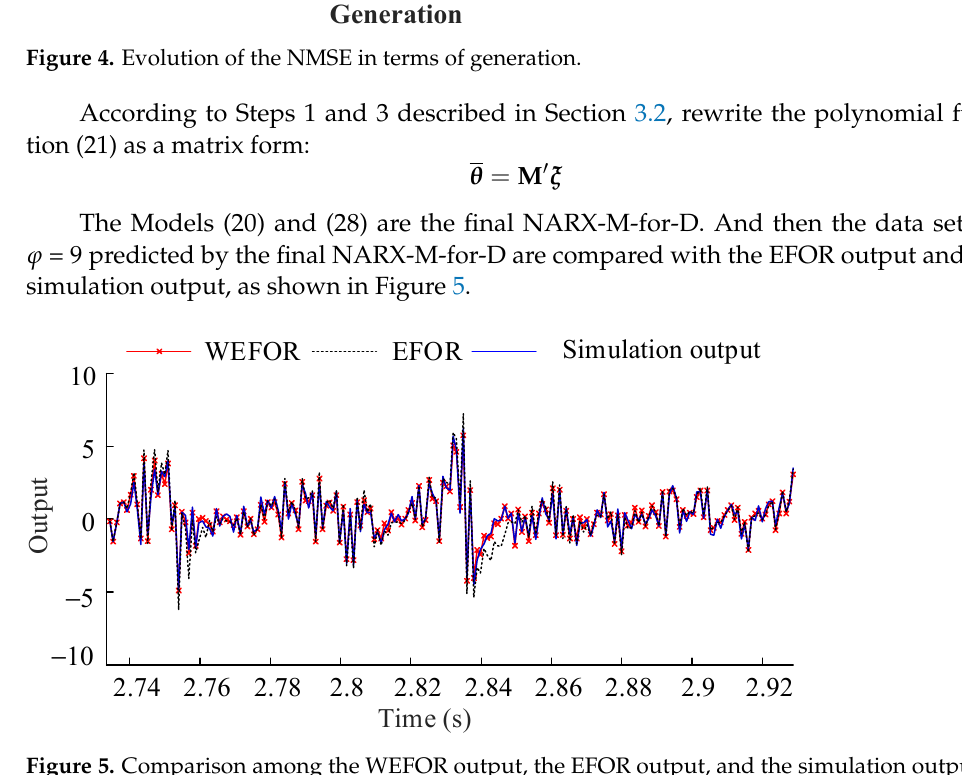
Figure 5. Comparison among the WEFOR output, the EFOR output, and the simulation output of φ = 9 by MPO.